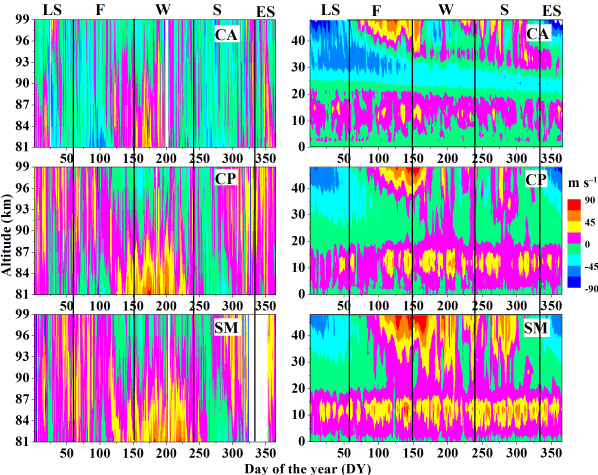
Figure 8. Bispectra in terms of normalized power calculated from the meteor zonal and meridional winds at 90km for three stations. Please note that the abscissa is ranged within 12–20days period to express QSDW and the ordinate is scaled within the range 2– 12days to show shorter periods.